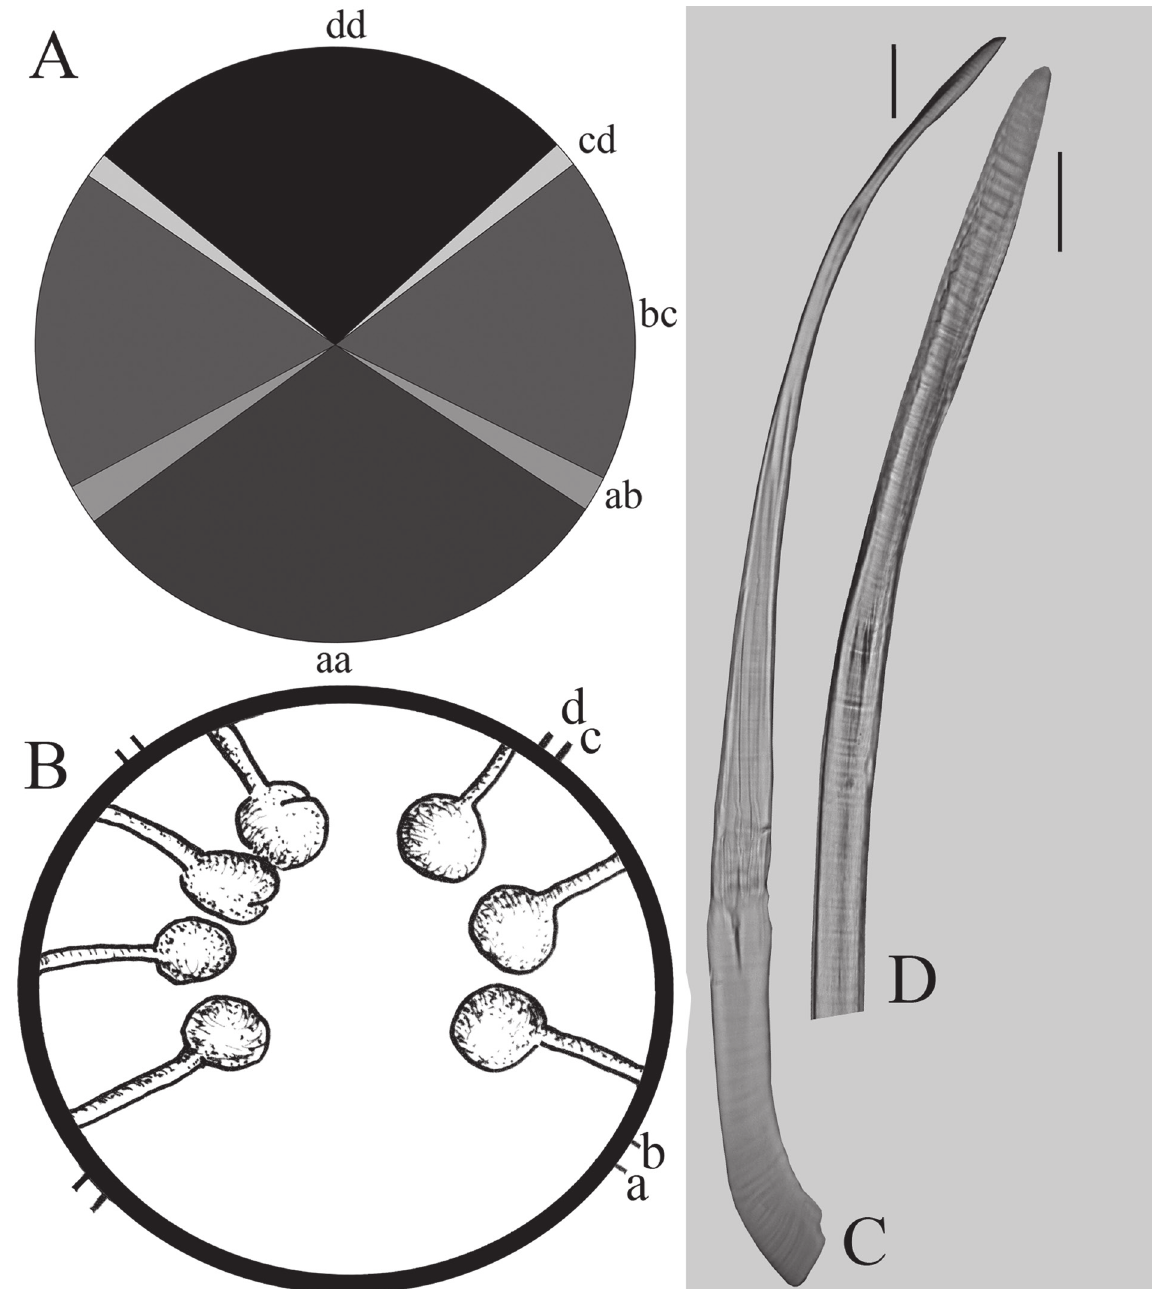
Fig. 3. K. blancharti sp. nov . A . Setal arrangement, a, b, c, d representing setal lines. B . Spermathecae (14/15) schematic representation. C . Genital seta. D . Tip of the genital seta. Scale bars = 0.1